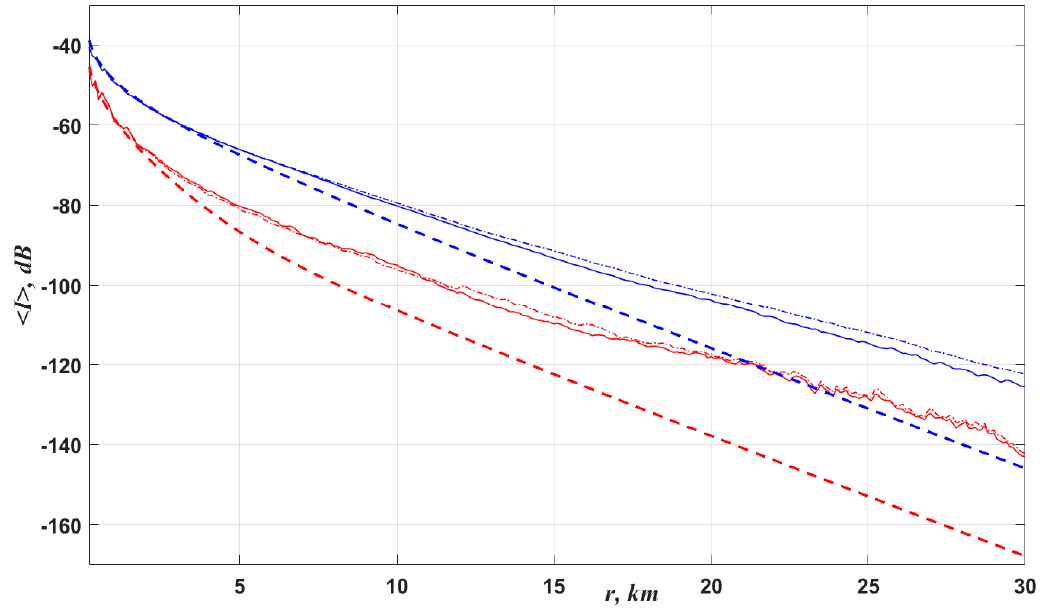
Figure 3. Similarly Figure 2 transmission loss for a waveguide with Gaussian fluctuations, L z = 20 m, L r = 4 km, and parameters of the bottom: c 1 = 1530 m / s, ( ρ 1 / ρ 0 ) = 1.5, β 1 = 0.01. H - z 0 = 42 m. Blue curves: H - z = 42 m. Red curves: H - z = 26 m. Thin dash curves correspond to the adiabatic approximation, thick dash curves represent a deterministic waveguide ( ε = 0).